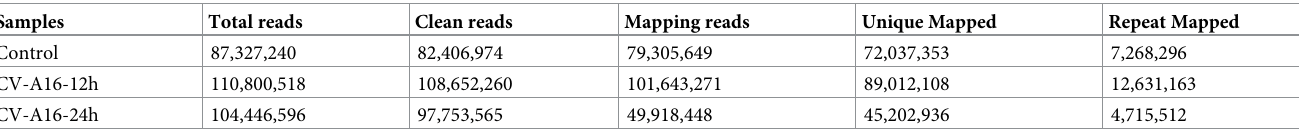
Table 1. Basic characteristics of transcriptome sequencing.